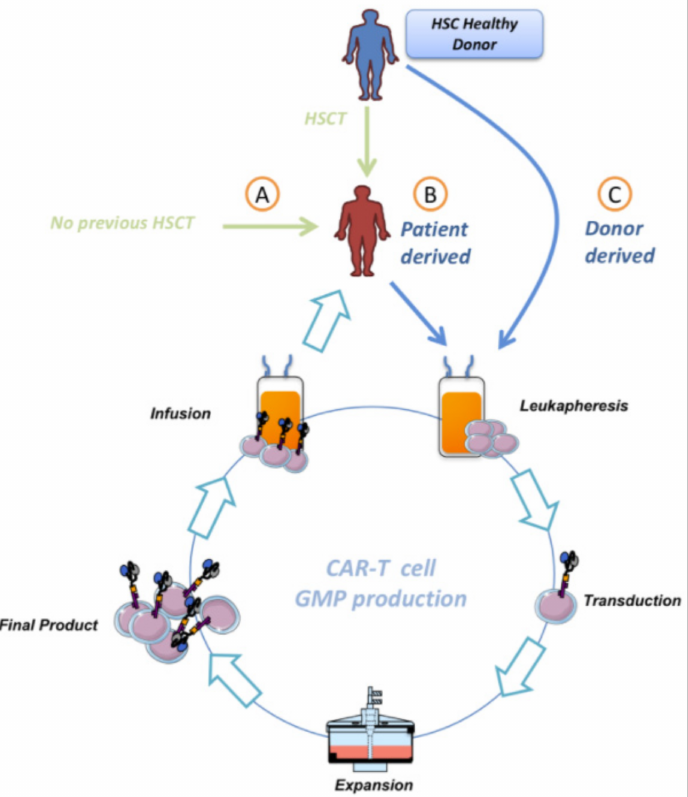
Figure 2. Different protocols in CAR-T therapy for B-cell malignancies. T-cells from patients with B-cell malignancies could be obtained from patients after HSCT (B) or without previous HSCT (A). Further, T-cells could be obtained from each recipient’s allo-HSCT healthy donor